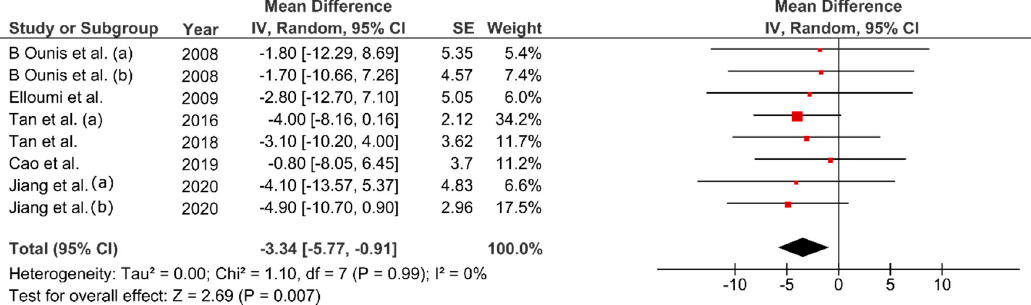
Figure 5. Pooled mean difference and 95% confidence interval for waist circumference (cm) change in fatmax training experimental groups: baseline vs. after intervention. Negative values indicate an improvement in body composition.